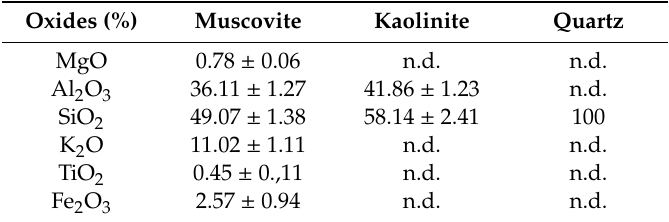
Table 2. Chemical analysis by EDX in natural kaolin.